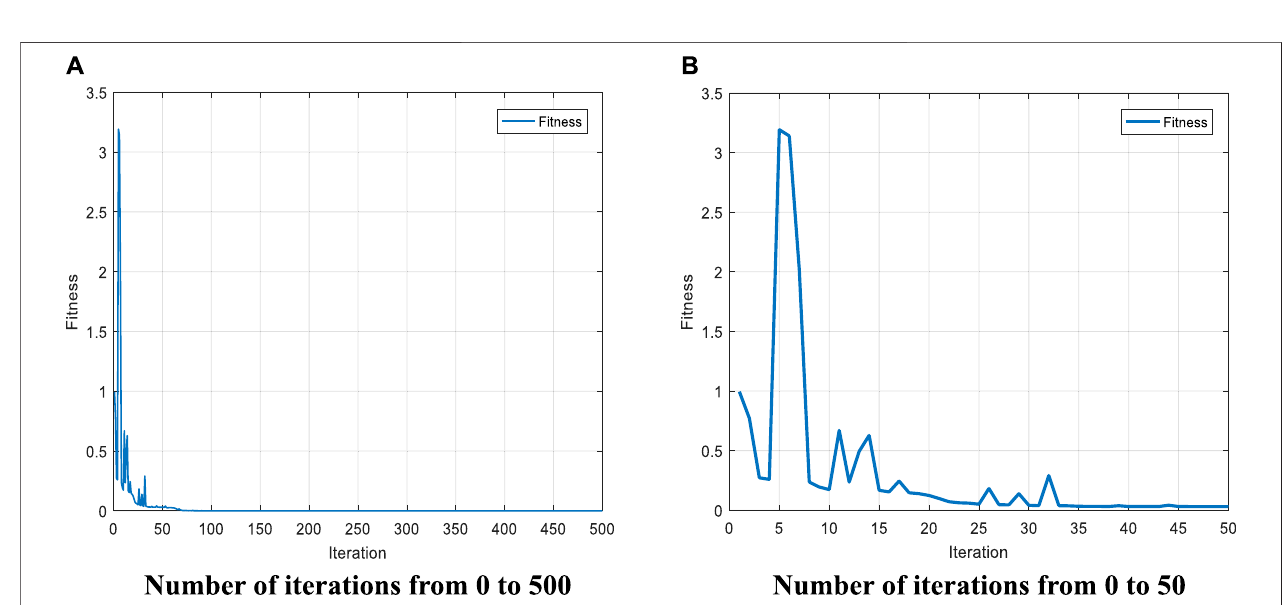
FIGURE 5 | Schematic diagram of different joint angles of the robotic arm end-effector in the same state.